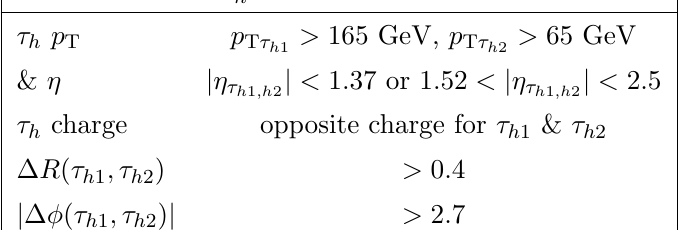
h (cid:28) h search [105]. Note that the p T cut